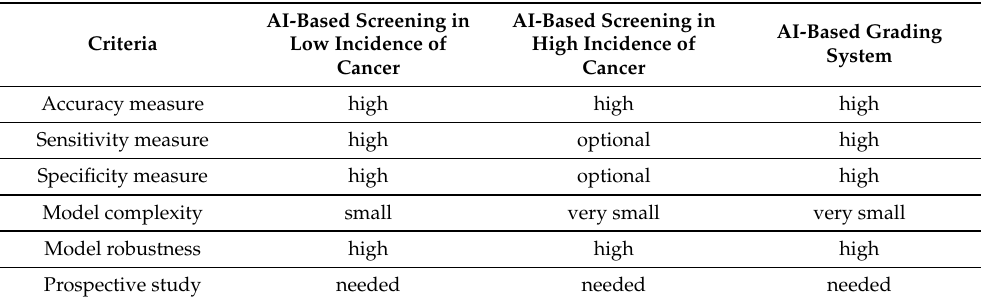
Table 11. Criteria for selecting machine learning techniques to support the decision of classifying BC from histopathological